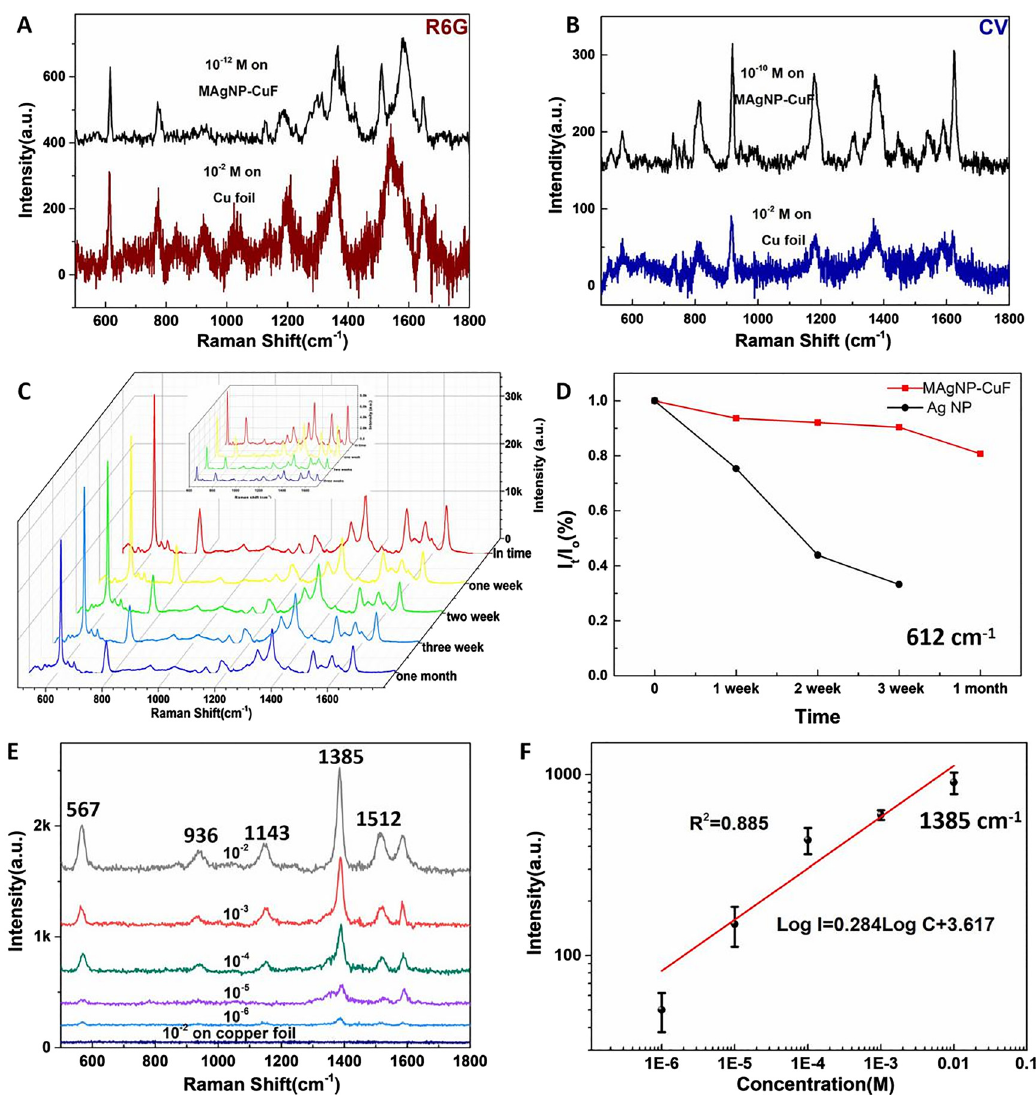
Figure 6: (A) and (B)The surface-enhancedRamanspectroscopy(SERS)spectraof R6G (10 − 12 M) andCV (10 − 10 M) collected from the four-layer MAgNP-CuF and the Raman spectra of R6G (10 − 2 M) and CV (10 − 2 M) collected from the Cu foil as comparison. (C)SERS spectra of R6G from MAgNP-CuF with different aging times. The inset in (C) exhibits the SERS spectra of R6G from Ag NP with different aging times. (D) SERS intensityratiosofthe I time and I origin forMAgNP-CuFandAgNP.(E)SERSspectraofthiramatvaryingconcentrationsrangingfrom10 − 2 to10 − 6 M. (F) Log − log plot of average intensity of SERS signals at 1385 cm − 1 versus the concentration of